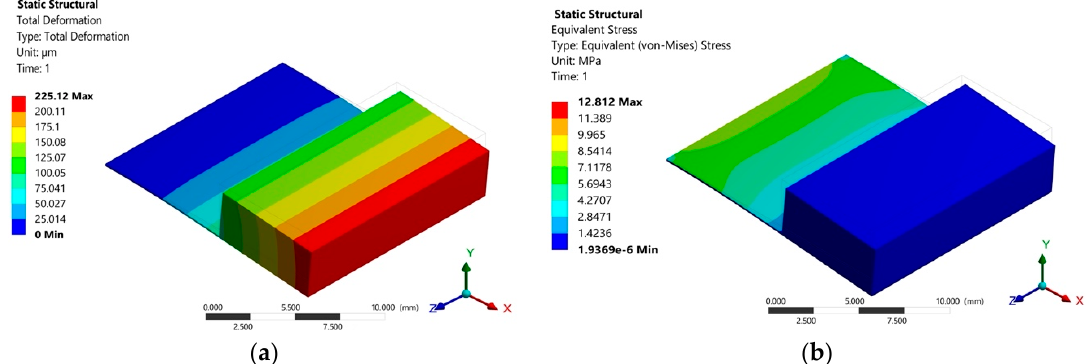
Figure 11. ( a ) Maximum static displacement and ( b ) maximum static stress of the FEM models of the pVEH microdevice caused by the weight of the seismic mass.